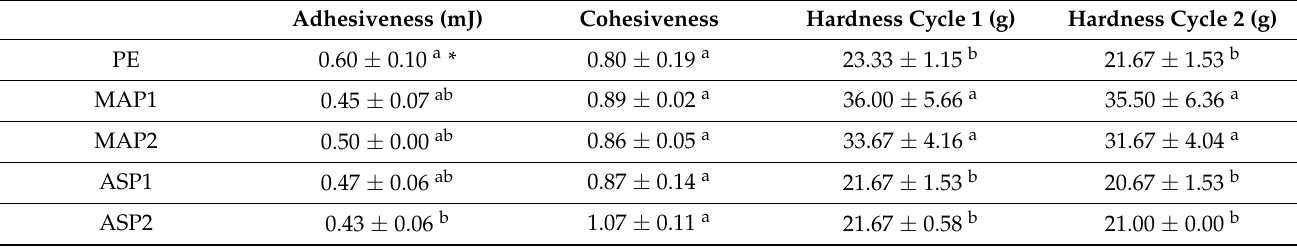
Table 4. The results of the texture analysis of tested